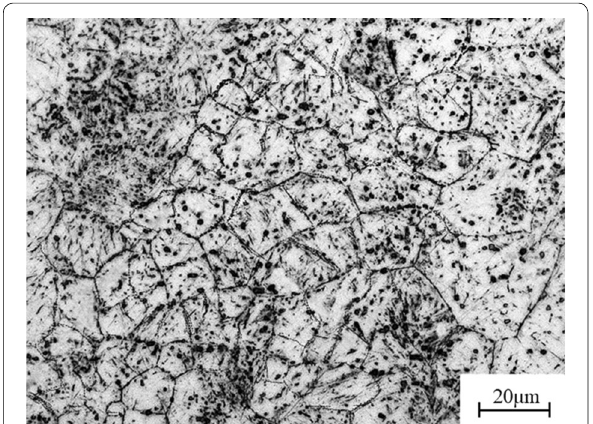
Figure 6 Image of original austenitic grain boundaries